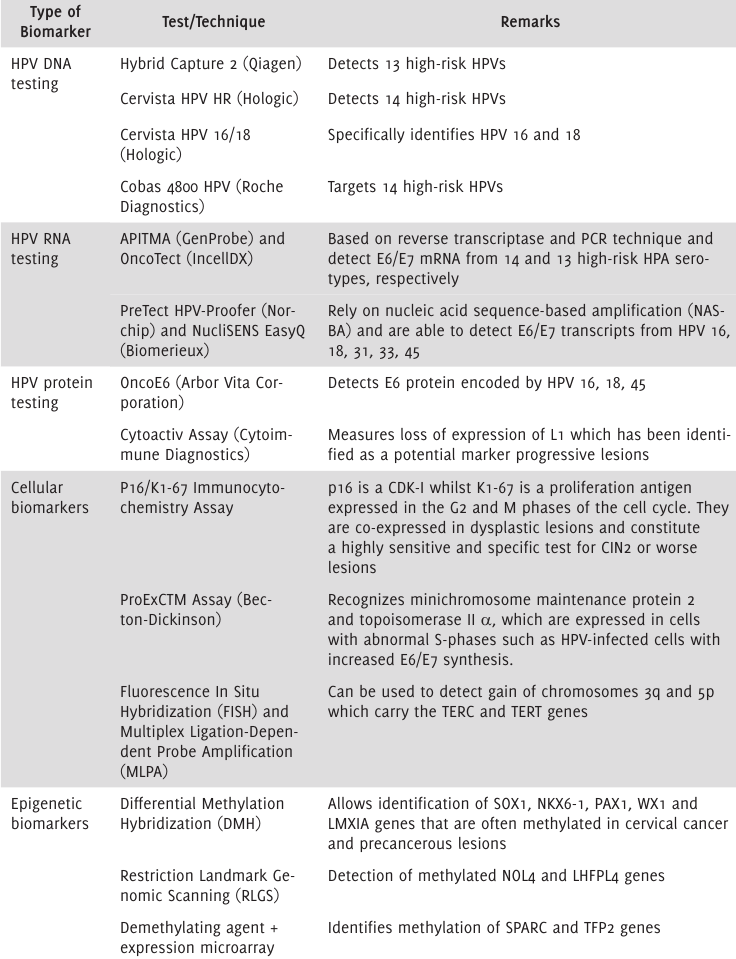
Table 3. Cervical Cancer